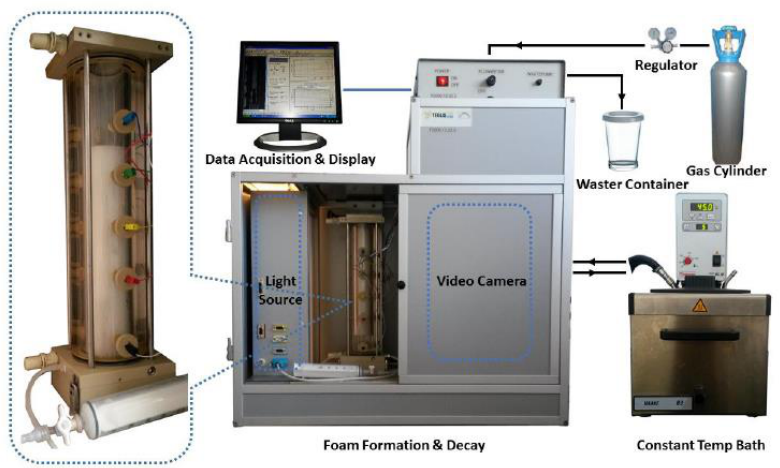
Figure 10. A schematic diagram of FoamScan setup.